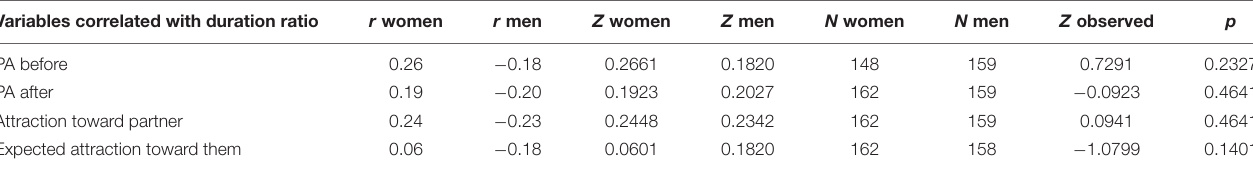
TABLE 3 | Comparison of the correlation coefficients related to time perception of both men and women. Variables correlated with duration ratio